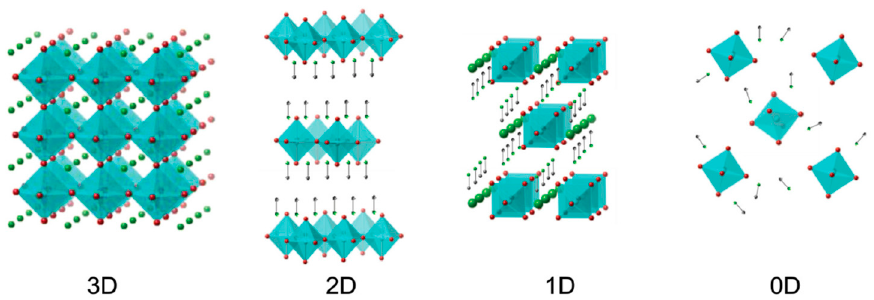
Figure 6. Overview of the different perovskite dimensionalities. Reproduced from ref. [79], with permission from John Wiley and Sons, 2015.